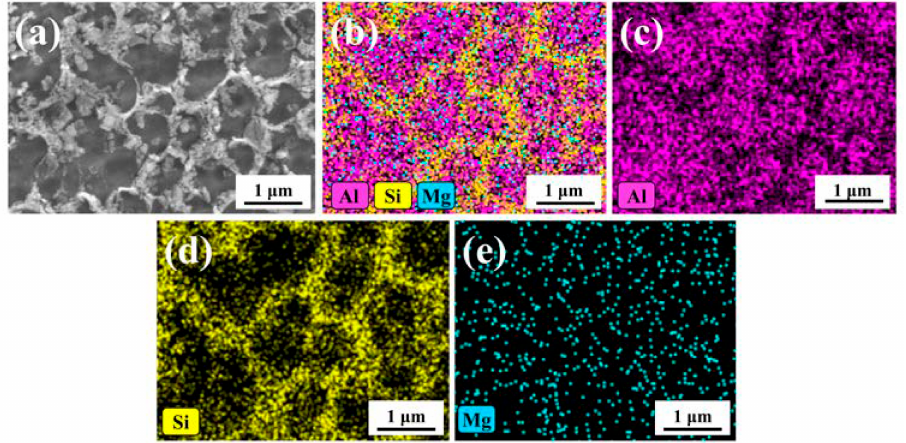
Figure 10. Energy-dispersive spectroscopy (EDS) analysis on the cross-section: ( a ) Morphology of cross-section, ( b ) Overall distribution diagram of elements, ( c – e ) The elemental distribution diagram of Al–Si–Mg on the cross-section.